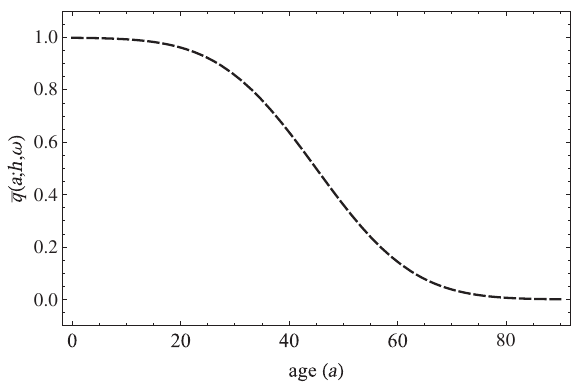
FIG. 22. Expected frequency Eq. (B20) with which new variant is used by speakers of different ages from a random sample. Mean and variance of speaker locations relative to left boundary x 0 of Δ ð 0 ; A Þ and ω 2 ¼ 1 . Model parameter transition region are h ¼ 1 2 values are a 0 ¼ 10 , A ¼ 90 , σ ¼ 5 , ϵ ¼ 0 . 1 . For these parameter values, ¯ a ¼ 35 . 23